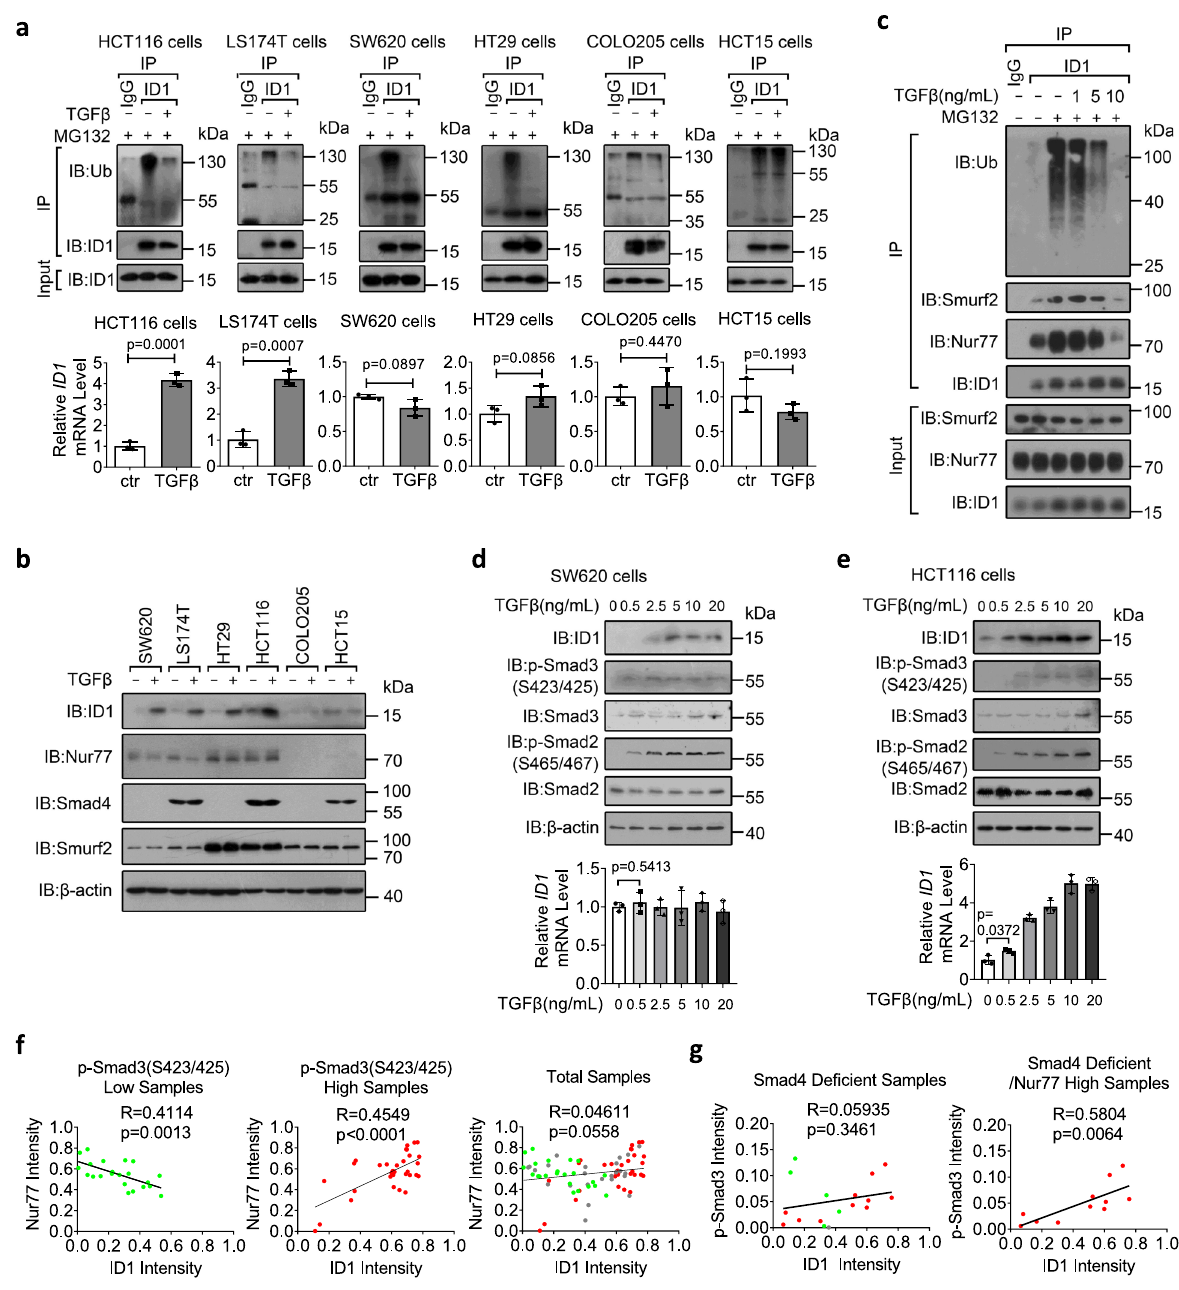
Fig. 6 Pathophysiological relevance of the TGF β /Nur77/ID1 axis in colon cancer. a Cells pretreated with MG132 (20 μ M) for 2 h were then treated with TGF β (10 ng/mL) for 1 h. ID1 ubiquitylation and mRNA expression were examined by co-immunoprecipitation and qRT-PCR, respectively. Ub ubiquitin. Two-tailed unpaired Student ’ s t test was used for statistical analysis, and data are presented as means± SD ( n = 3 biologically independent samples). b Cells were treated with TGF β (10 ng/mL) for 1 h and protein expression was examined by immunoblotting using the indicated antibodies. c SW620 cells were treated with MG132 for 2 h and then with TGF β at the indicated doses for 1 h. ID1 ubiquitylation and protein interactions were examined. d , e SW620 ( d ) and HCT116 ( e ) cells were treated with TGF β at the indicated doses for 1 h. IB and qRT-PCR were applied to examine protein and ID1 mRNA expressions, respectively. The phosphorylation of Smad2 and Smad3 were detected using anti-p-Smad2(S465/467) and anti-p-Smad3(S423/425) antibodies, respectively. Two-tailed unpaired Student ’ s t test was used for statistical analysis, and data are presented as means ± SD ( n = 3 biologically independent samples). f , g Immunohistochemistry analysis of clinical colon cancer samples showing correlations of ID1 expression with Nur77 expression and TGF β signal activity. The green ( n = 22) and red ( n = 33) dots represented tissue samples with low and high TGF β signal activity, respectively ( f ). The green ( n = 5) and red ( n = 11) dots represented tissue samples with low and high Nur77 expression, respectively ( g ). Two-tailed correlation analysis was used to indicate correlation (assume data were sampled from Gaussian population). Data represent at least two independent experiments. Source data are provided as Source Data fi